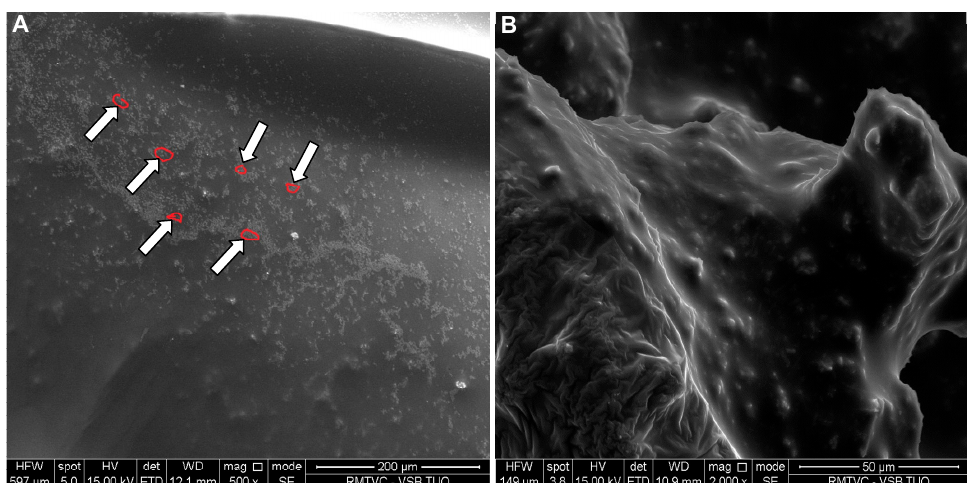
Figure 8. SEM image of risedronate with polysorbate 80 (Sample 2c ) at magnification 500× ( A ) and 2000× ( B